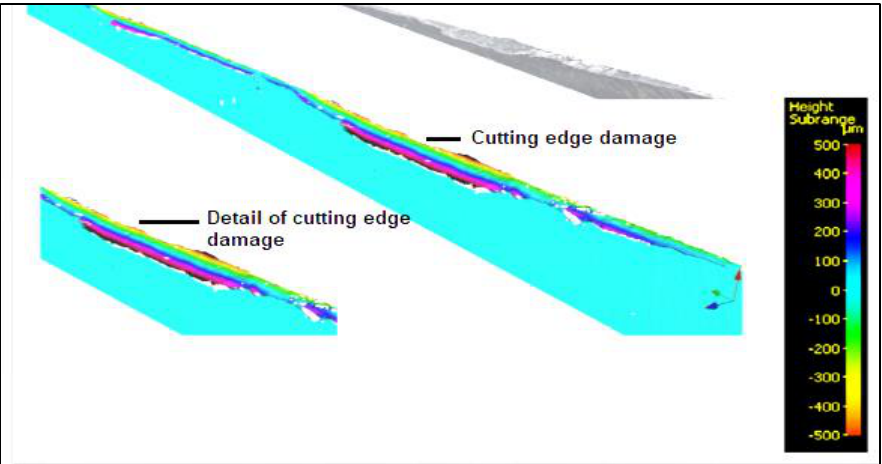
Figure 7. Cutting force and the path of the delimbing knife in the process of chipless wood cutting.